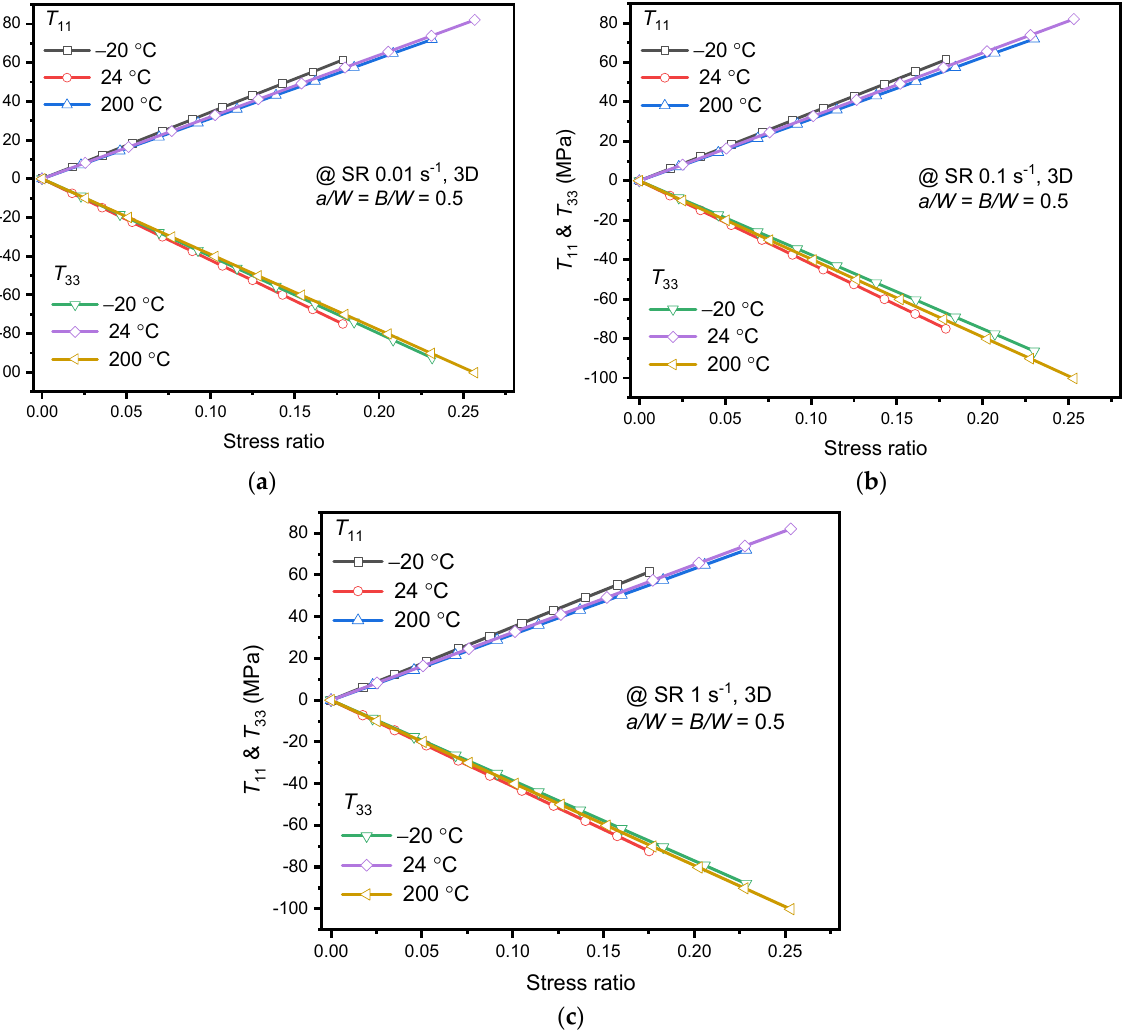
Figure 10. T 11 and T 33 at specimen thickness center obtained using FEA for different temperature